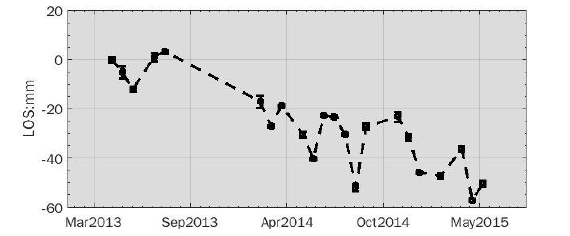
Fig 6. Deformation of point D